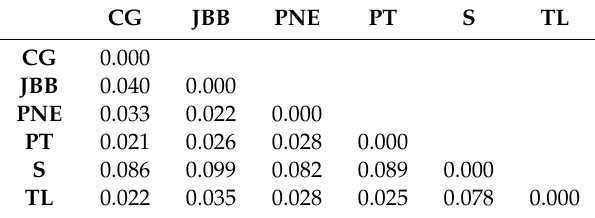
Table 3. Genetic distance of Myrcia bella populations from di ff erent regions of Cerrado. CG JBB PNE PT S TL CG